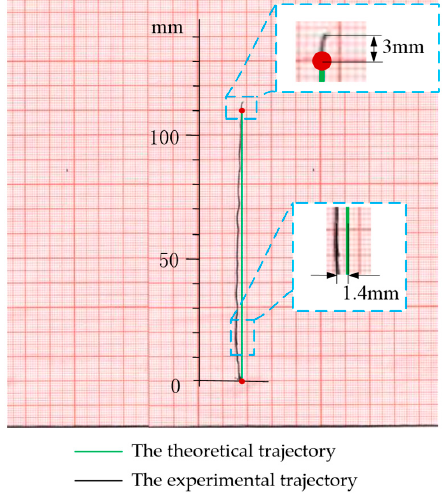
Figure 14. Comparison of the foot trajectory between theory and experiment. Table 3. Trajectory sampling analysis results.